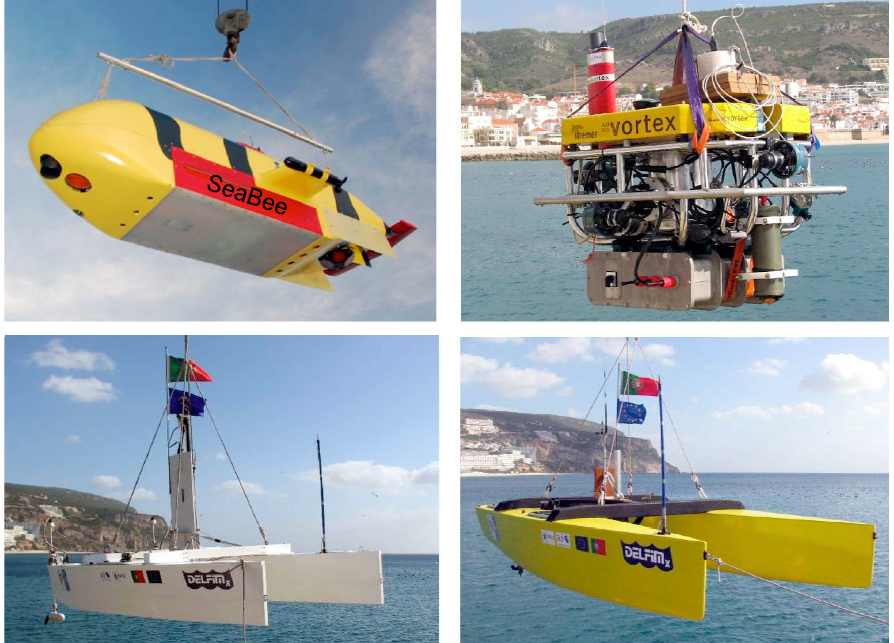
Figure 1. Heterogeneous vehicle used to demonstrate cooperative motion control during GREX trails at Sesimbra,